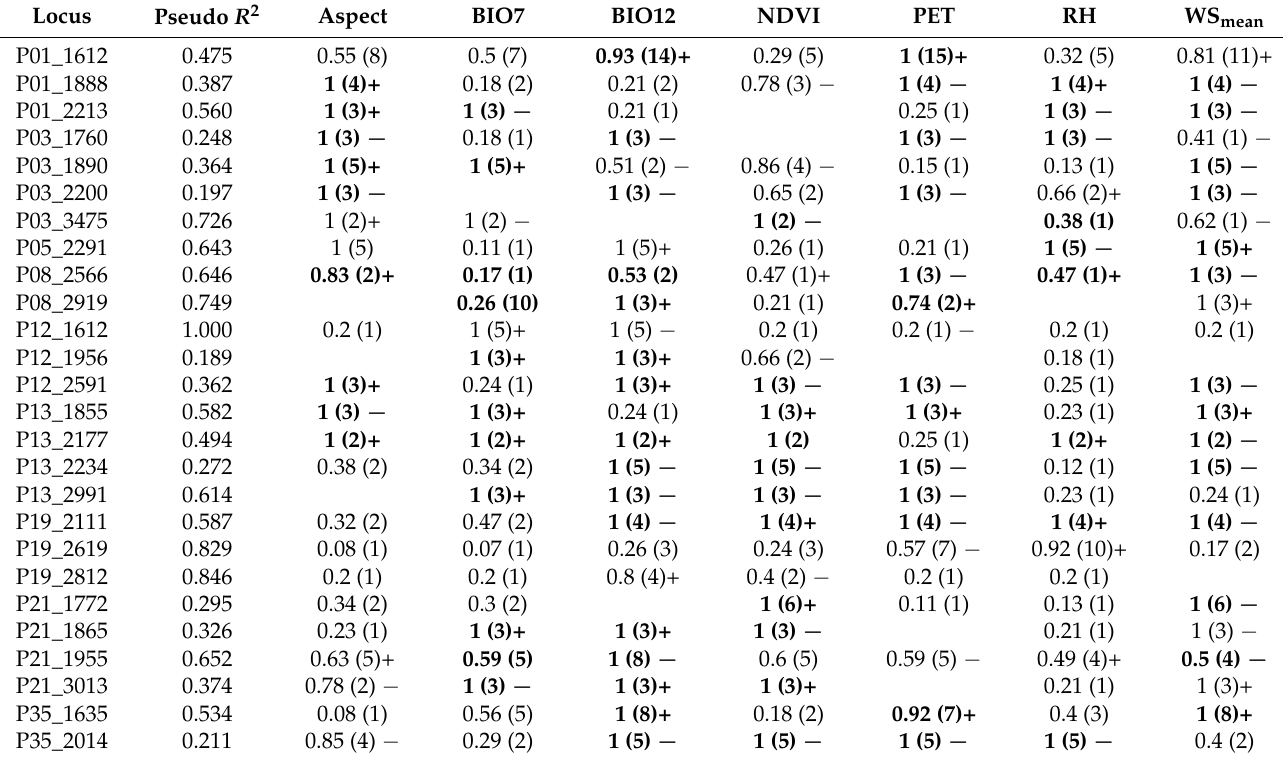
Table 5. Relative importance and significance of environmental variables explaining variations in the 26 F ST outliers based on model averaging using MuMIn. Numbers in parentheses are the Akaike sum of weights (SW) of each environmental variable across all parsimonious predicting models ( ∆ AICc ≤ 2). In bold, variables receiving strong support (i.e., the 95% confidence interval did not overlap with zero). McFadden’s pseudo R 2 was calculated with the variables (predictors) selected as the best model with the lowest AICc used in the generalized linear model. For variables that are part of the best model with the lowest AICc, the sign of regression coefficient is shown: +, positive; − ,